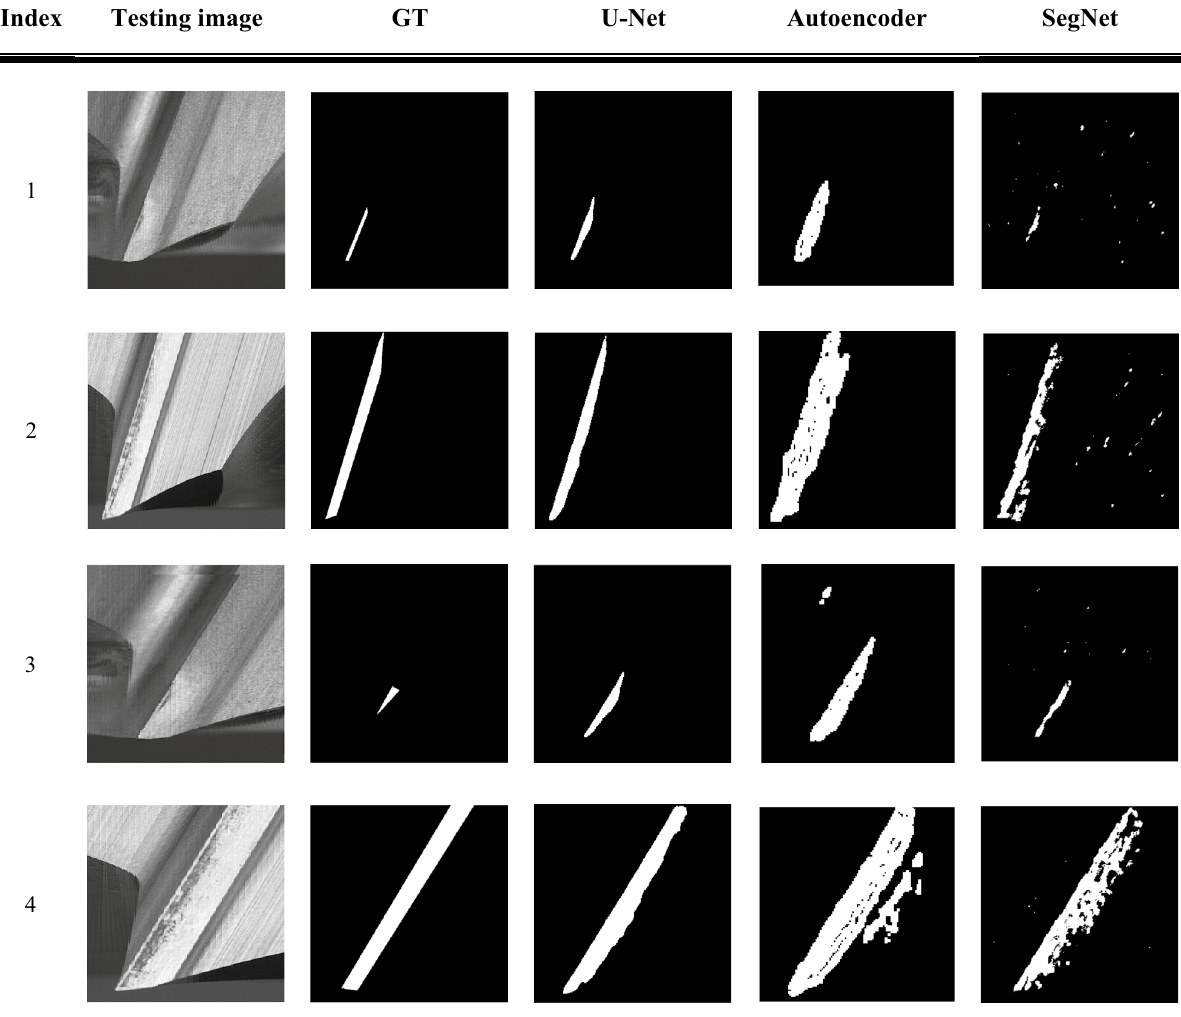
Table 7. The comparison of detecting the tool wear areas by using three models.